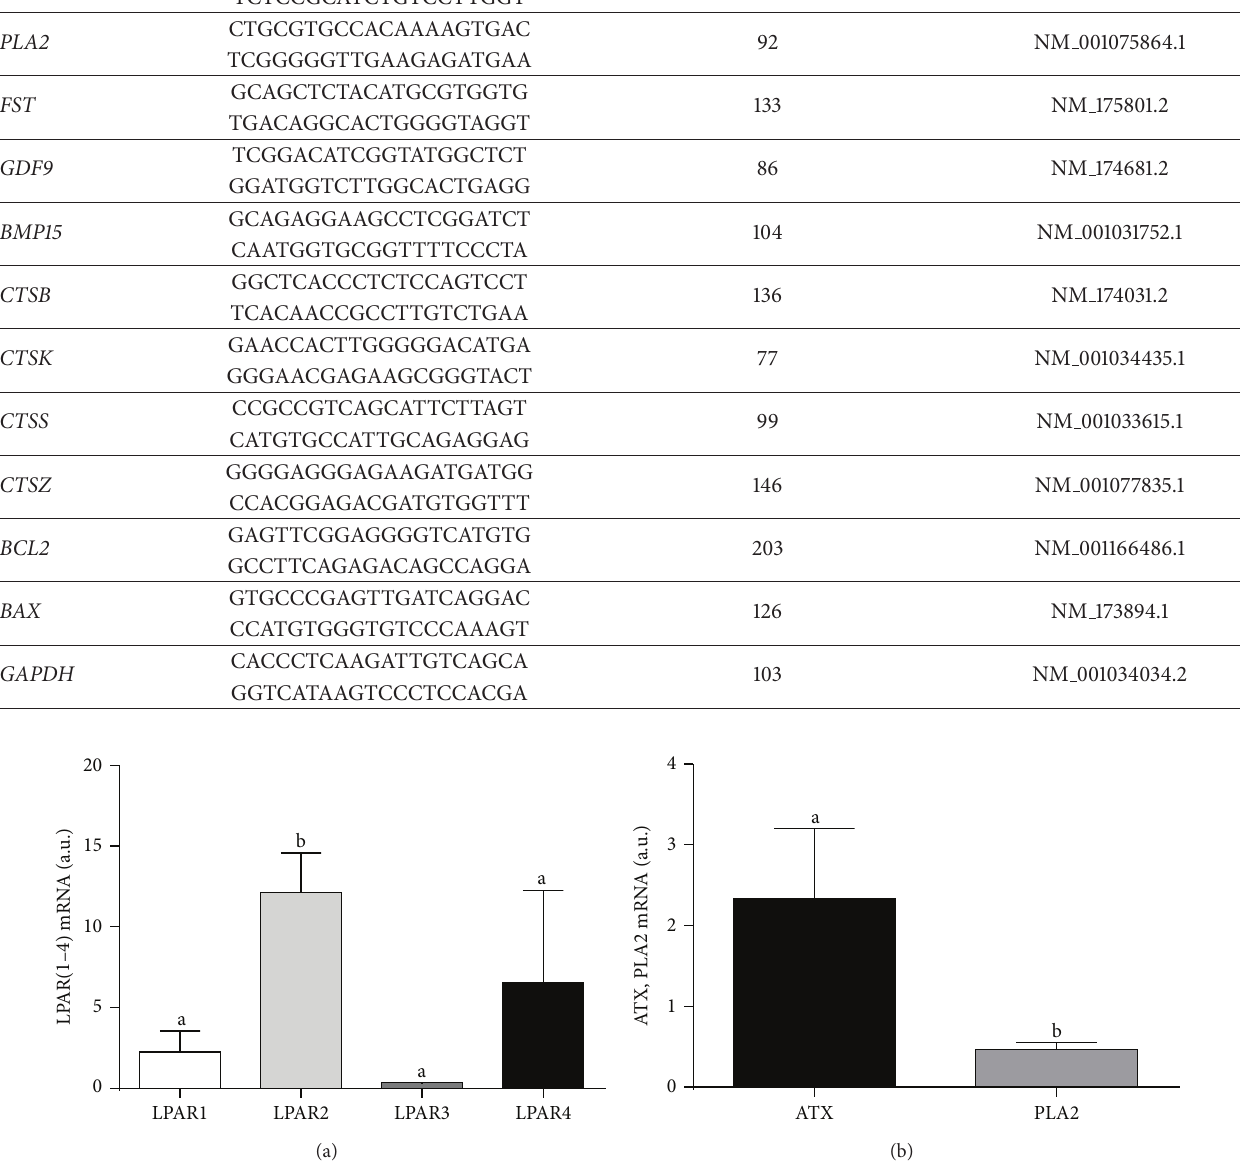
Figure 1: mRNA expression of (a) LPA receptors ( LPAR1–4 ) and (b) autotaxin ( ATX ) and phospholipase A2 ( PLA2 ) in oocytes. The values are expressed as mean ± SEM. Different letters indicate significant differences ( 𝑃 < 0.05 ), as determined by one-way ANOVA and Student’s 𝑡 -test,